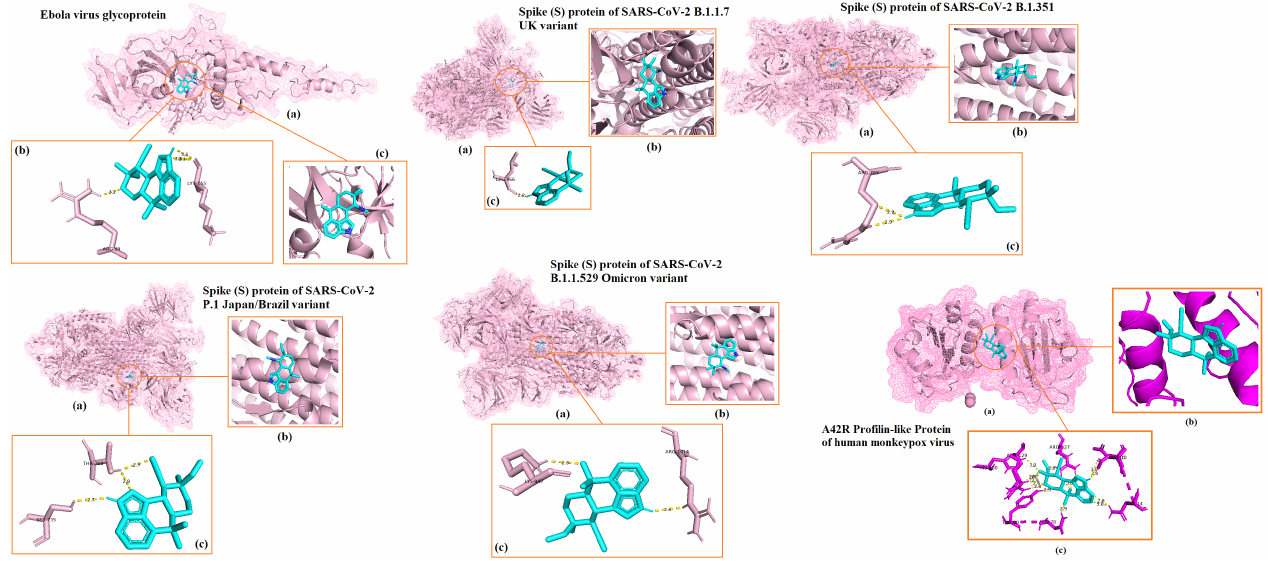
Figure 5. Results of the docking analysis showing the 6 main binding sites of hapalindole H with the different viral surface proteins. The molecular interactions in the 3D structures were visualized in PyMOL. ( a ) Indicates binding domain. ( b ) Binding site. ( c ) Interacting amino acids of receptor (purple) and ligand